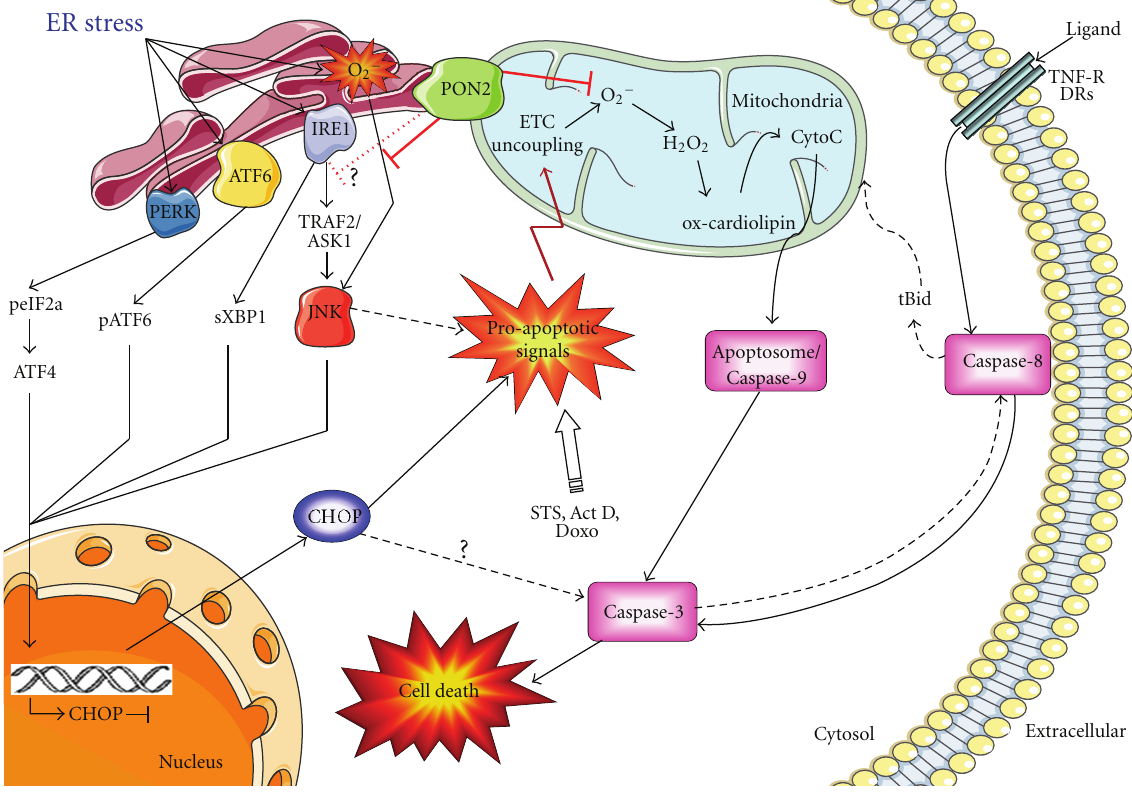
Figure 3: Schematic presentation of the suggested antiapoptotic mechanism of PON2 and PON3. Its ability to prevent mitochondrial O 2 − formation impacts on both ER stress-induced pathways (via acting on JNK and CHOP) as well as mitochondrial proapoptotic signaling such as cardiolipin peroxidation and cytochrome C release. See text for details. From our current understanding, PON2 is functionally interchangeable with